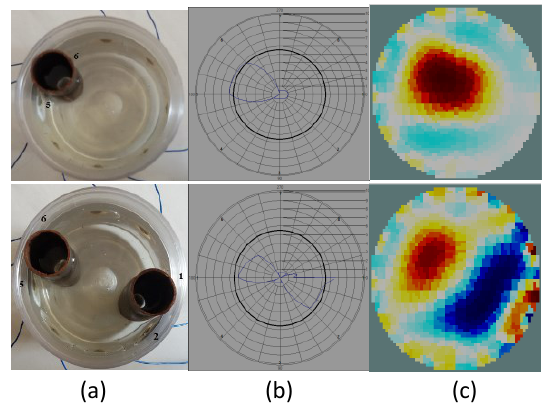
Fig. 8: (a) A single test object placed between electrode positions 5 and 6 (top). Two test objects placed between electrode positions 1-2 and 5-6 (bottom). (b) The beamforming algorithm gives a flat beam across electrode positions 5 and 6 (top) and a flat beam across electrode positions 1-2 and 5-6 (bottom). (c) EIDORS results for the given locations of the test